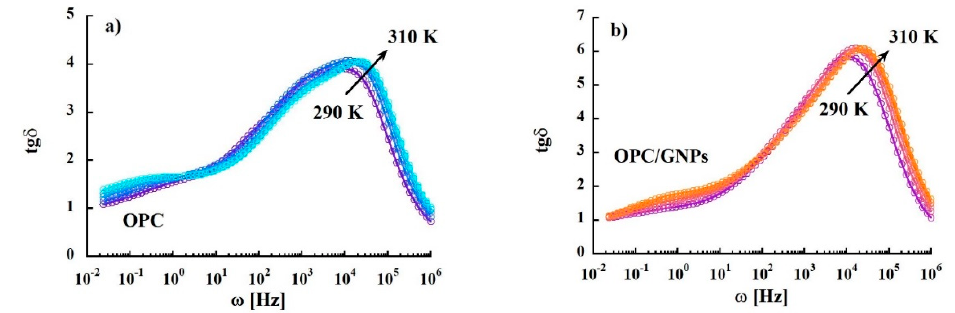
Figure 7. Variation of loss tangent in OPC ( a ) and OPC/GNPs ( b ) as a function of frequency in the temperature range 290–310 K.